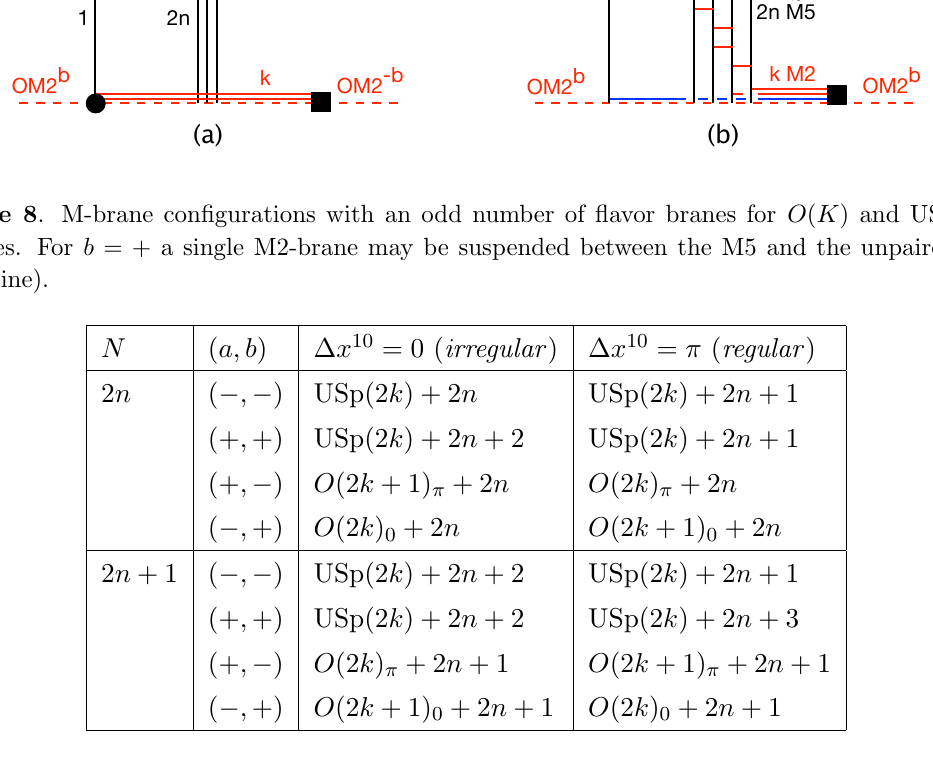
Table 3 . Theories described by the OM2 M-brane